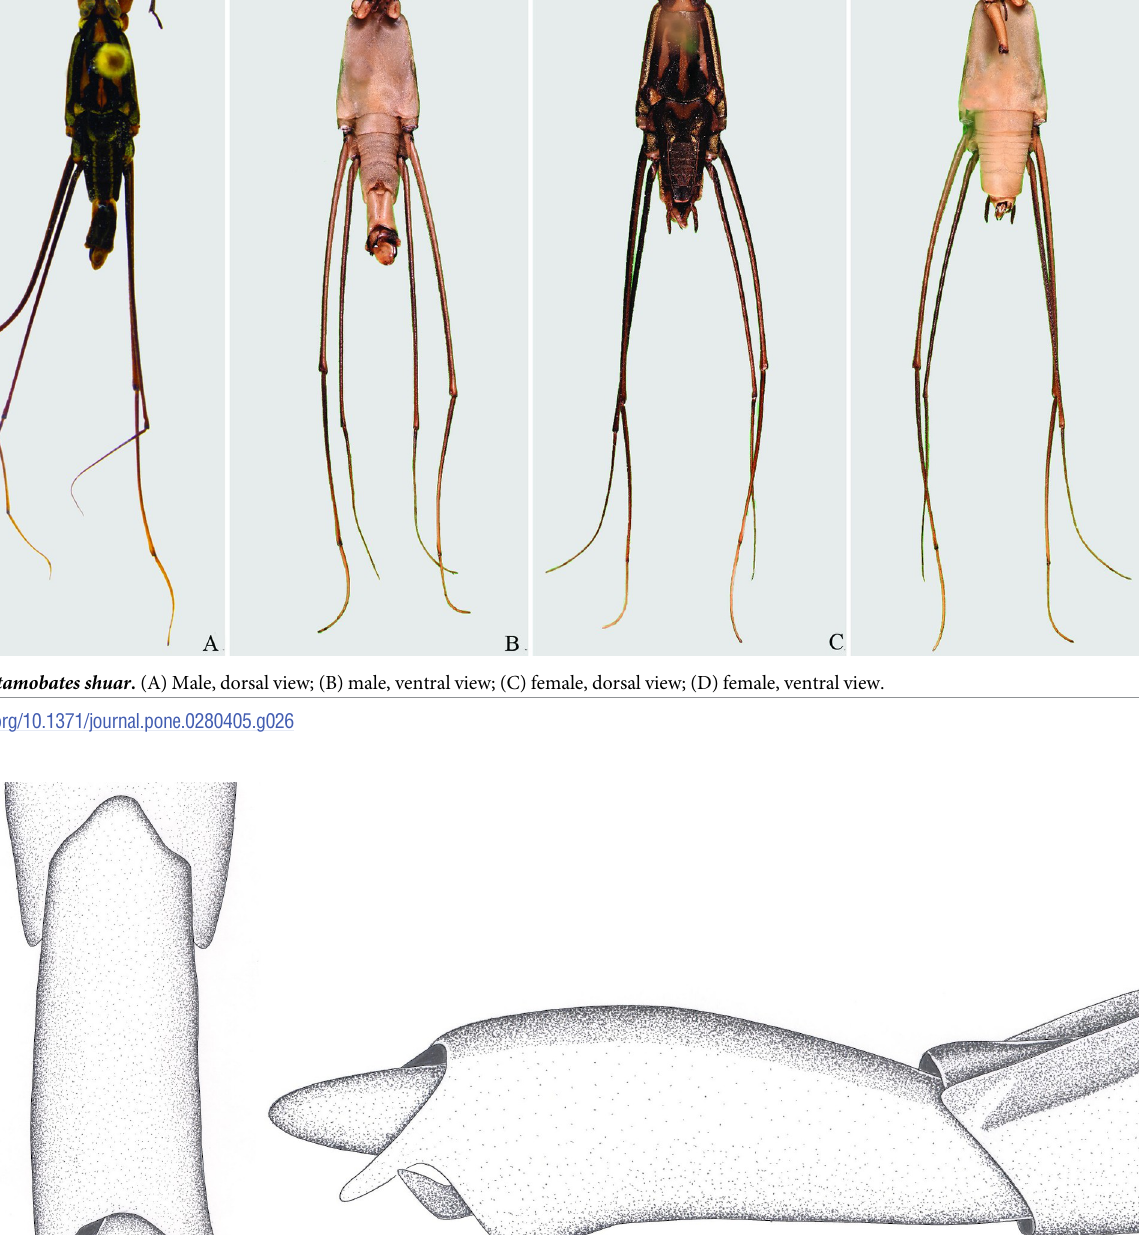
PLOS ONE | https://doi.org/10.1371/journal.pone.0280405 March 8, 2023 28 /